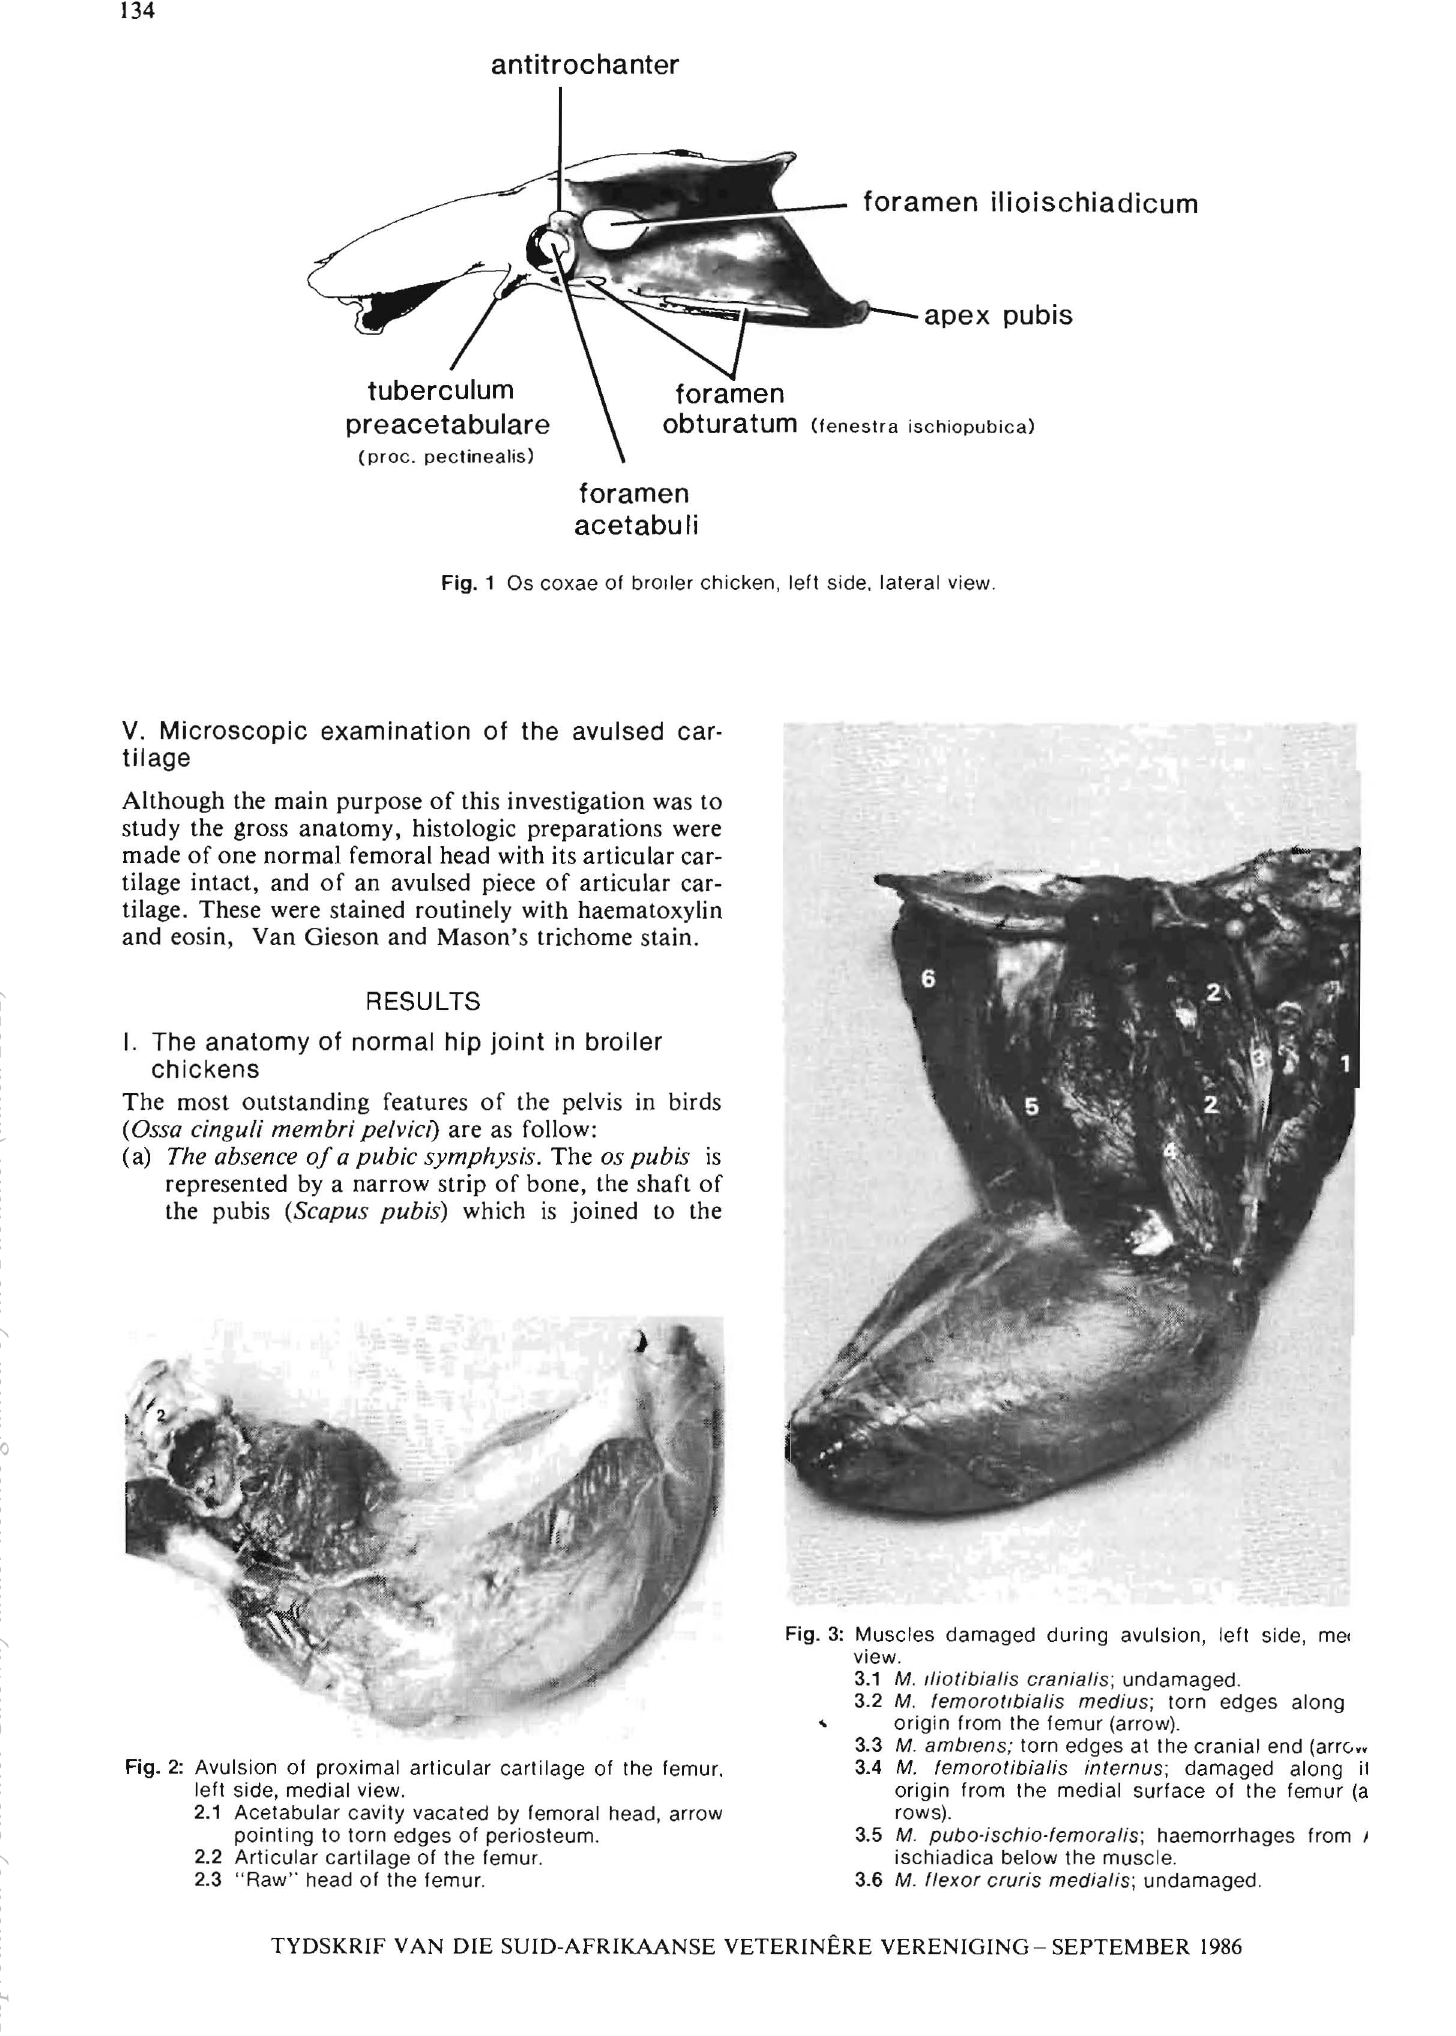
Fig. 2: Avulsion of proximal articular cartilage of the femur. left side, medial view. 2.1 Acetabular cavity vacated by femoral head, arrow pointing to torn edges of periosteum. 2.2 Articular cartilage of the femur. 2.3 " Raw" head of the femur.